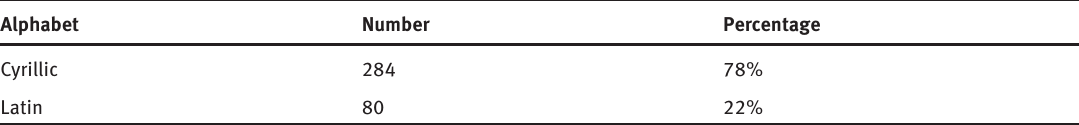
Table 2. Use of English nouns in Cyrillic or Latin